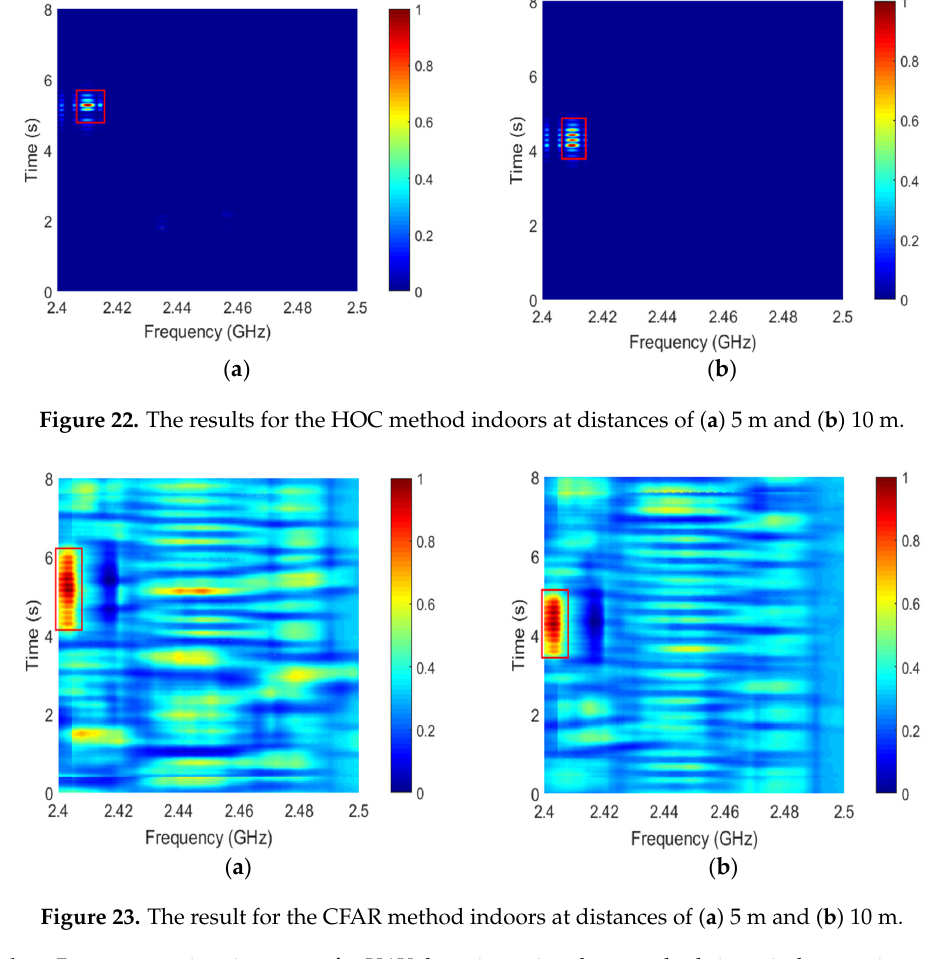
Figure 21. The DOA estimation using the proposed method indoors at distances of ( a ) 5 m and ( b ) 10 m.